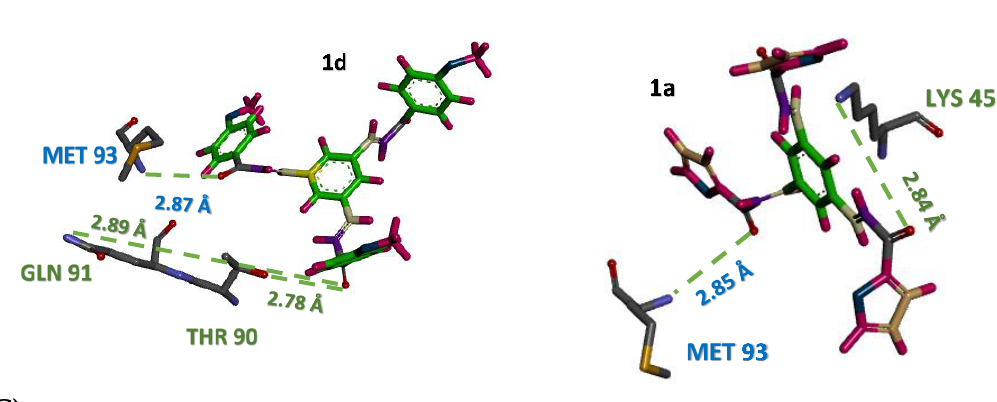
Figure 3.6. MD simulation: Stick representation